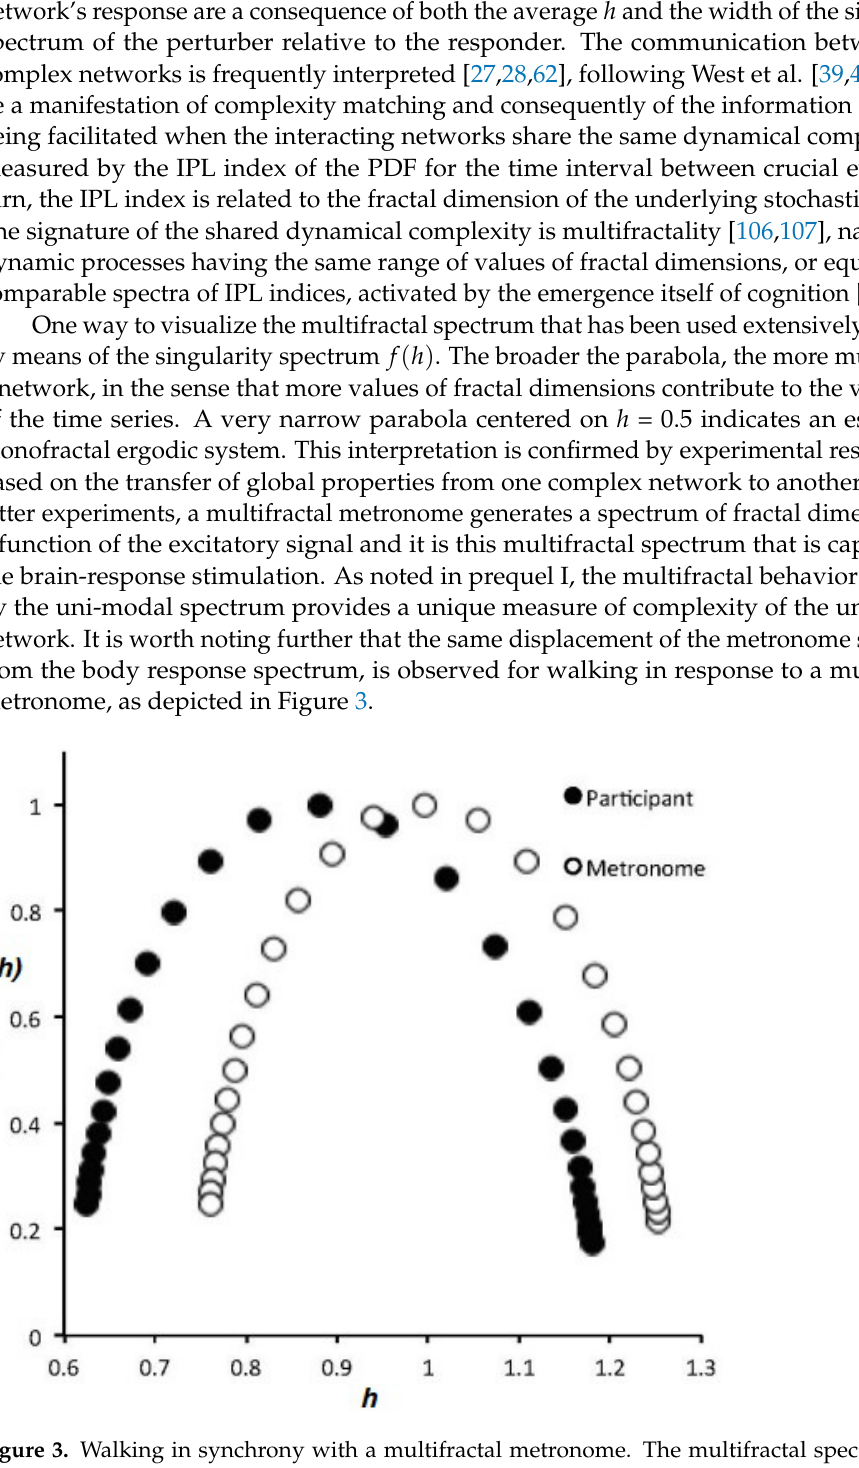
Figure 3. Walking in synchrony with a multifractal metronome. The multifractal spectra for the participant (black circles) and that for the metronome (white circle) are shown. This figure is derived with permission from the left panel of Figure 3 in